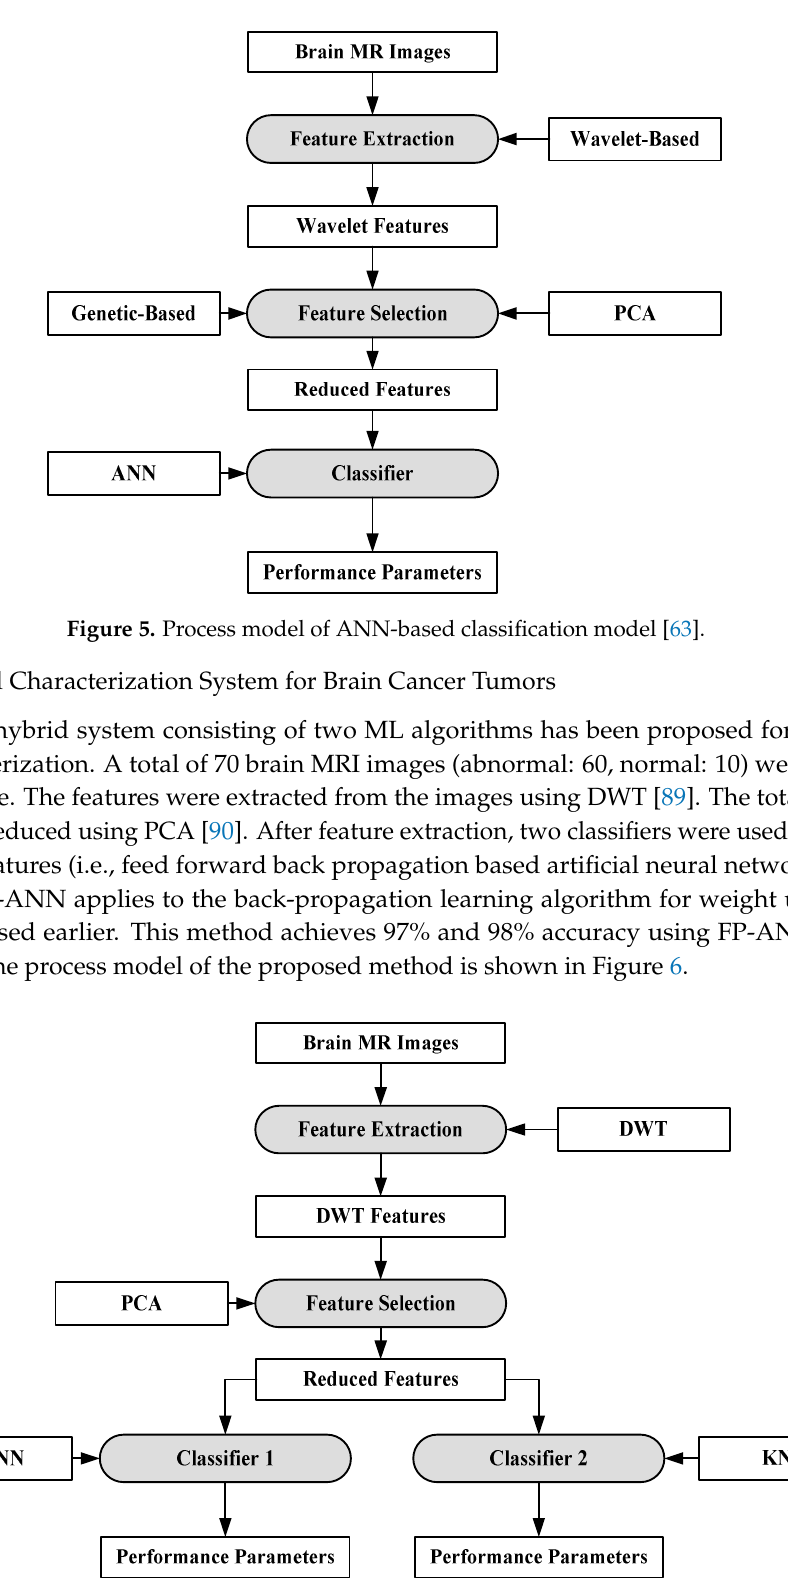
13 of 32 Figure 4. Brain MR images: ( a ) normal brain, ( b ) benign tumor (7 O’ clock arrow) and ( c ) malignant tumor (7 O’ clock arrow) (reproduced from [63] with permission).